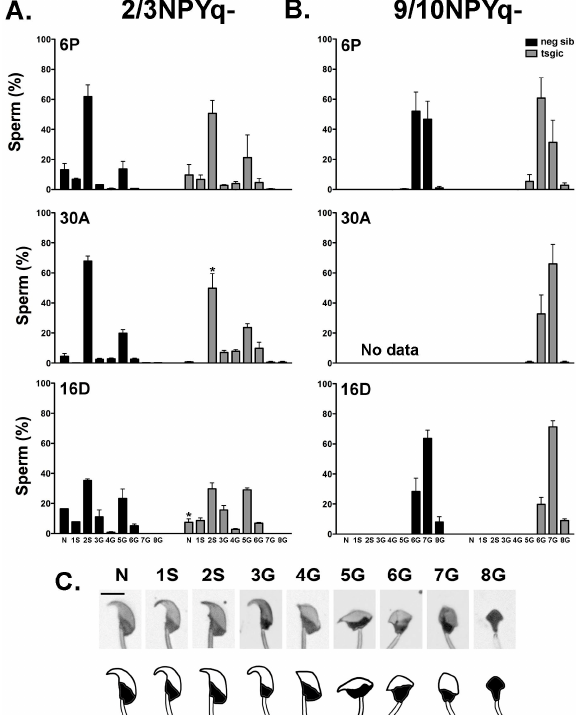
Figure 4. Addition of the Flag-Sly transgene does not rescue sperm morphology defects in males with NPYq deficiency. Sperm headshape was evaluated in mice with moderate ( A , 2/3NPYq-) and severe ( B , 9/10NPYq-) deficiency with (tsgic) and without (neg sib) the Flag-Sly transgene. Three transgenic lines were tested: 6P positive for both the Sly1 and Sly2 transgenes (top), and 30A (middle) and 16D (bottom) positive for the Sly1 transgene. Normal headshape (N) and eight categories of headshape defects (slight: 1S-2S and gross: G3–G8) were differentiated ( C ). The data represent an average ± SDev with n = 2–4 males per genotype and 300 sperm examined per male (A) or average ± SDev with n = 3–4 males per genotype and 100 sperm examined per male (B). The photo/diagram composite (C) was published by us before (Figure 4 in Reference [8] ); Bar = 5 µm. No data for neg sib are shown for line 30A because no transgene negative siblings were obtained in ICSI trials. Statistical significance: two-way ANOVA with genotype and sperm headshape as factors, revealed no effect of genotype ( p > 0.05) and a strong effect of headshape ( p < 0.0001) for all groups tested. The interaction effect ( p < 0.05) was present only for 2/3NPYq- 30A and 16D groups. The results of paired comparison for specific sperm headshape types between transgenic and negative siblings in a post-hoc Bonferroni test are shown within the graphs: * p <